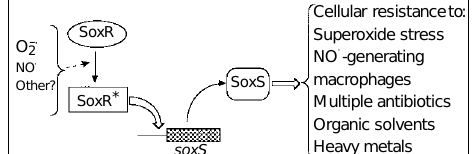
Figure 2 - Two-stage gene acti- vation in the soxRS regulon. Synthesis of SoxS protein trig- gers resistance genes. SoxR*, the activated form. NO, Nitric oxide. Reprinted with permis- sion from Ref.